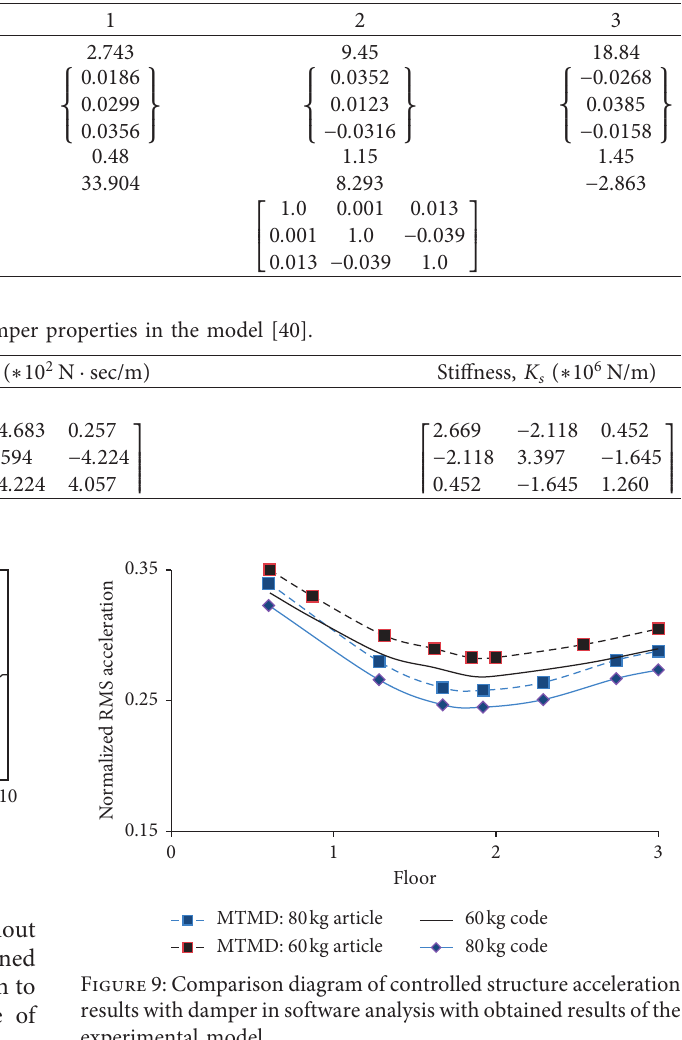
Figure 7: Studied structure on the shaking table [40]. Table 6: Modal properties of structure [40].